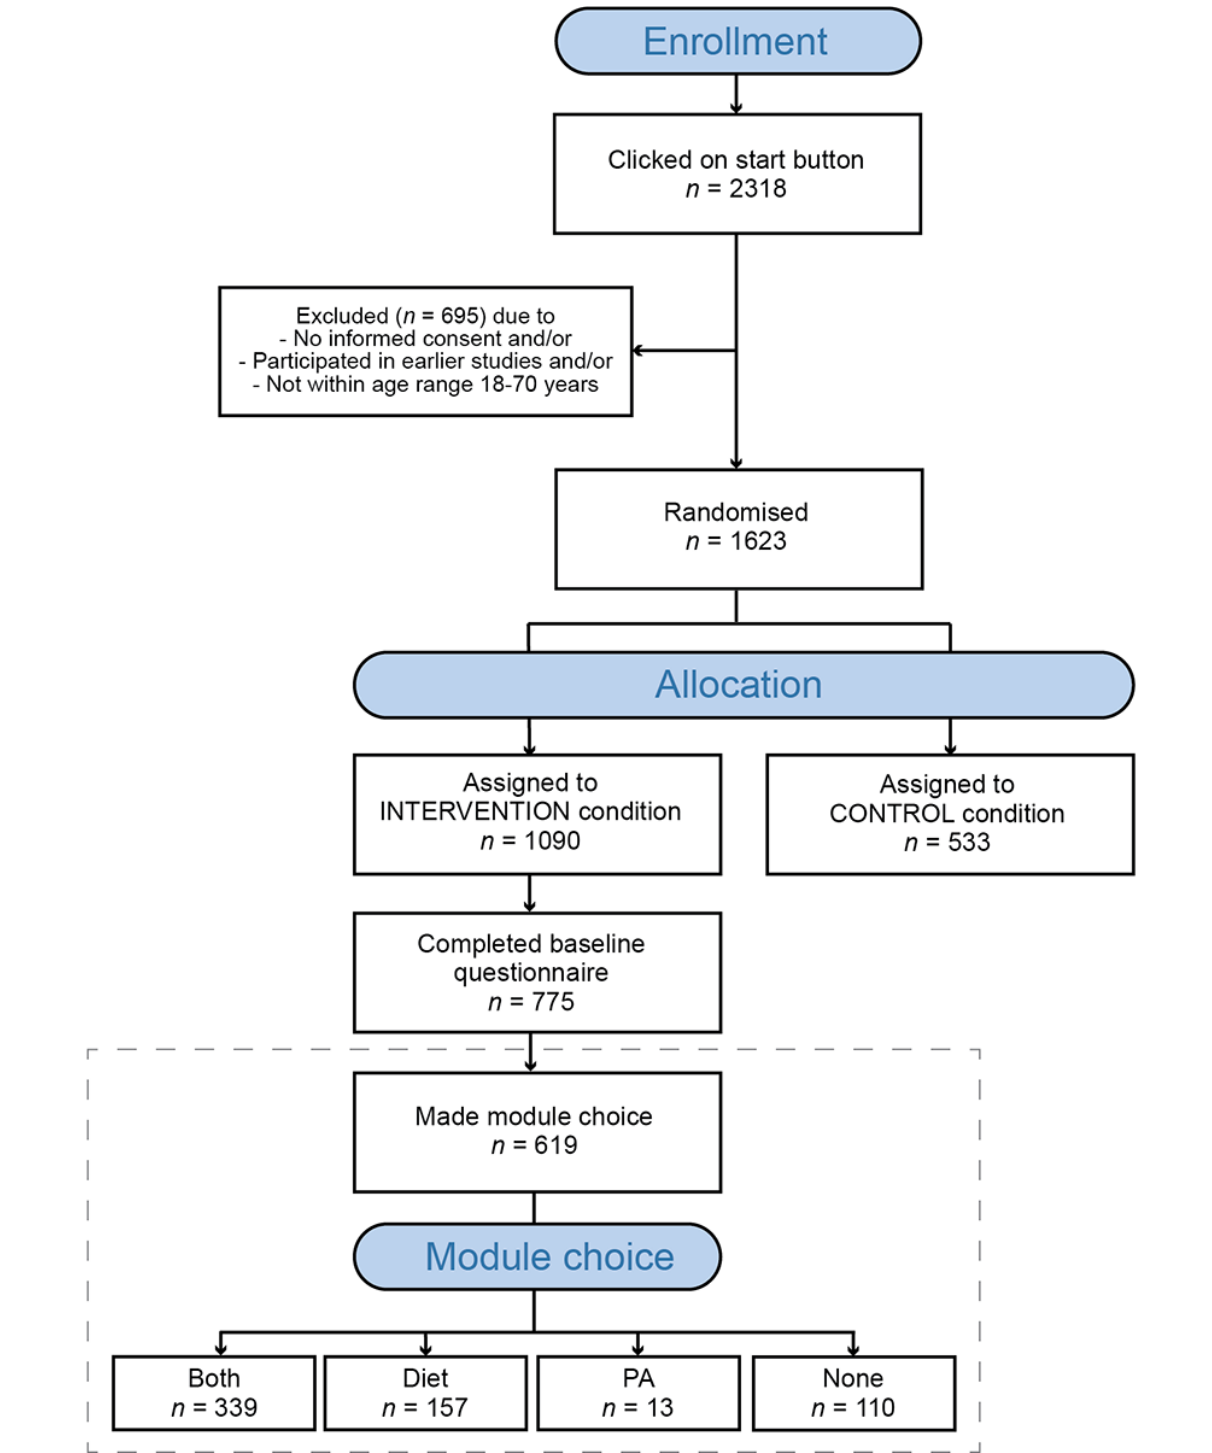
Figure 1. Overview of the study